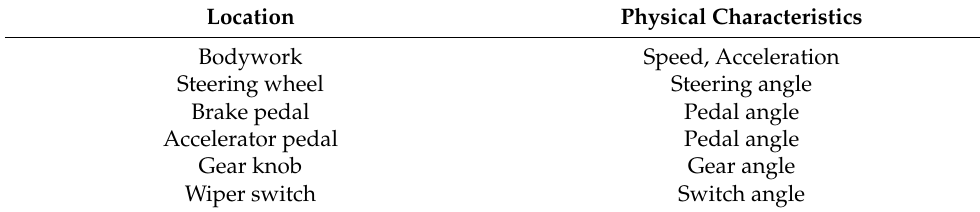
Table 3. Methods and results of raw data processing.